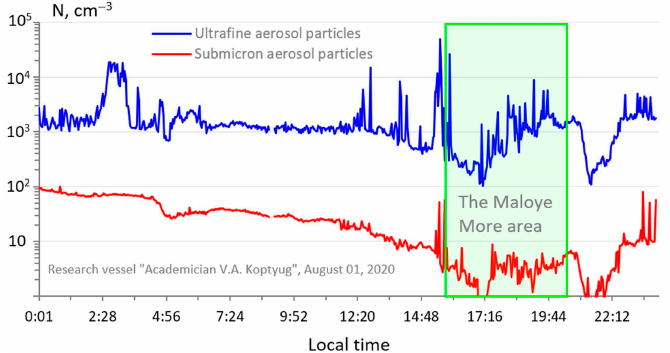
Figure 5. Time course of the particle number concentration of the microdispersed aerosol fraction in the Maloye More area, 1 August 2020.